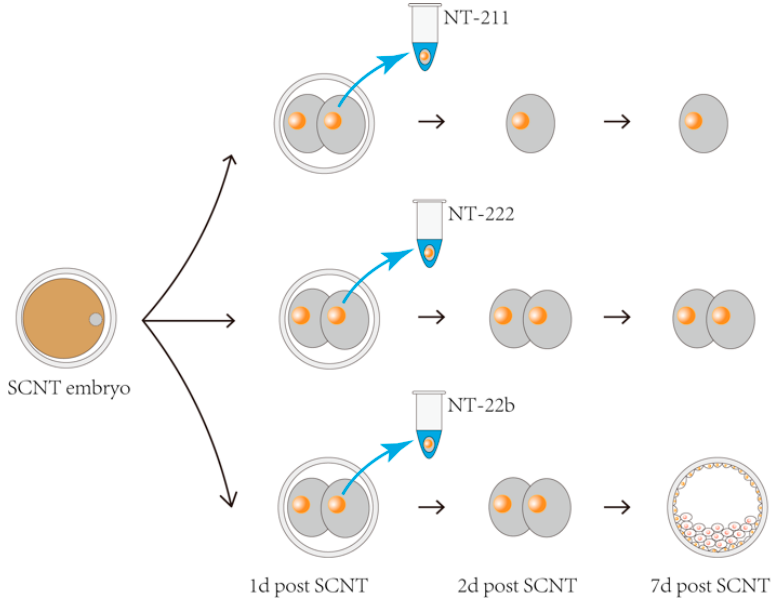
Figure 1. Schematic diagram of the sampling and grouping of cloned porcine embryos. One blastomere was isolated at the two-cell-stage and frozen for later microproteomic analysis. The frozen blastomeres were divided into groups NT-211, NT-222, and NT-22b according to the developmental fate of the remaining blastomeres in each embryo. The NT-211, NT-222, and NT-22b groups represent the SCNT embryos arrested at the two-cell stage (with only one cell), the SCNT embryos arrested at the four-cell stage (with two cells), and the SCNT embryos that developed to the blastocyst stage, respectively.